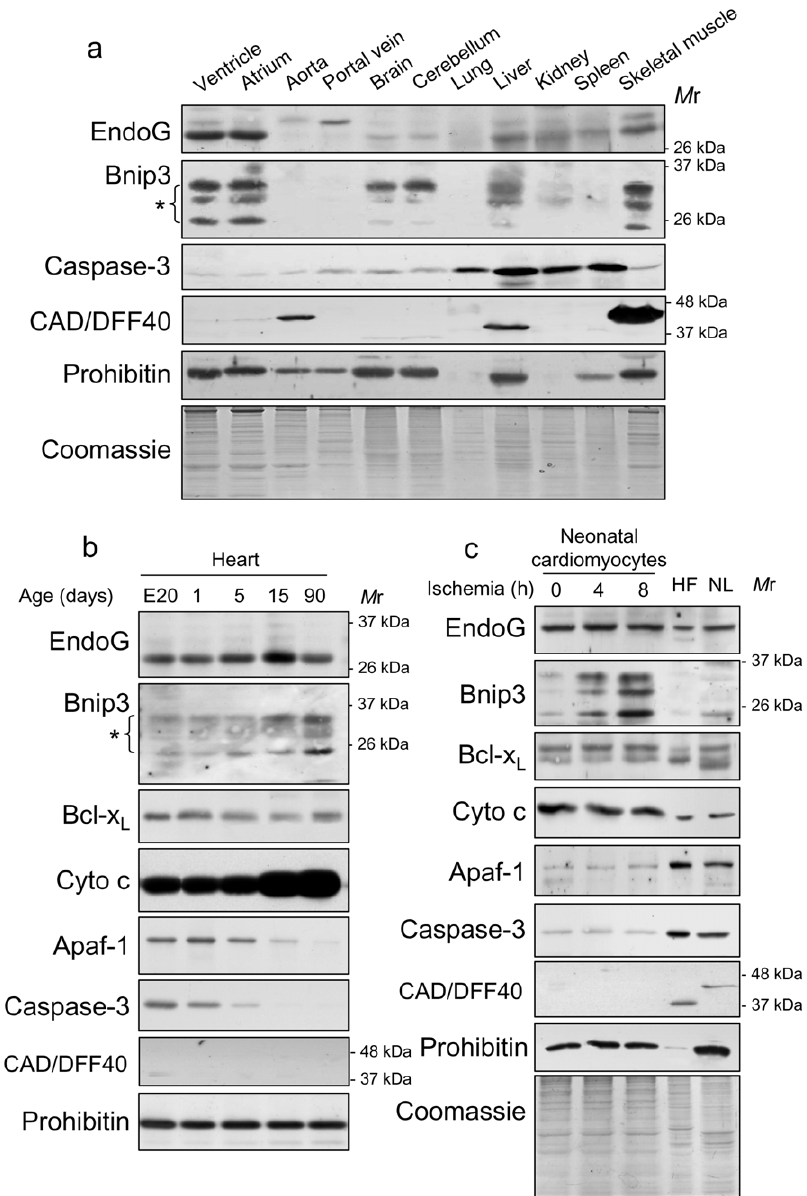
Figure 1. EndoG and Bnip3 are most highly expressed in rat heart, and are located to cardiac myocytes thorough development and during ischemia. a) Western blot analysis of EndoG, using a new anti-EndoG antibody (AntibodyBcn, BCN4778) and Bnip3 protein expression in total protein extracts from different adult rat tissues. EndoG is detected as a single band ( , 27 kDa) and Bnip3 is detected as a group of bands around the 26 kDa mark (asterisk), in agreement with the information provided by the manufacturer. Both proteins are expressed mainly in the heart and skeletal muscle. Detection of EndoG and Bnip3 was performed in two different sets of independent samples with similar results. b) Western blot detection of EndoG, Bnip3 and proteins involved in caspase-dependent cell death in total protein extracts of ventricles from rats of different ages ranging from embryonic day 20 to adulthood. A representative image is shown from three independent experiments. c) Neonatal cardiomyocytes were treated with ischemia and the abundance of EndoG, Bnip3 and proteins involved in the caspase-dependent pathway was analyzed by Western blot in extracts obtained at different time points. Primary heart fibroblasts and neonatal liver samples were added for comparison. A representative image is shown from three independent experiments. doi:10.1371/journal.pone.0017998.g001 FLAG. Fixation with PFA allowed detection of EndoG-FLAG expression in cytosolic extracts of cardiomyocytes in the same even when released from mitochondria. In empty virus-transduced conditions confirmed that Bcl-x L overexpression prevented ischemic cardiomyocytes the pattern of EndoG-FLAG expression EndoG-FLAG release from mitochondria (Figure 5c). To was diffuse (Figure 5a), suggesting translocation, which was complete these results, we fixed other cultures from the same significantly prevented in cardiomyocytes overexpressing Bcl-x L experiment with methanol. This procedure allowed co-staining of EndoG-FLAG and the mitochondrial marker Hsp60, demonstrat- (Figure 5a and b). Western blot analysis of EndoG-FLAG